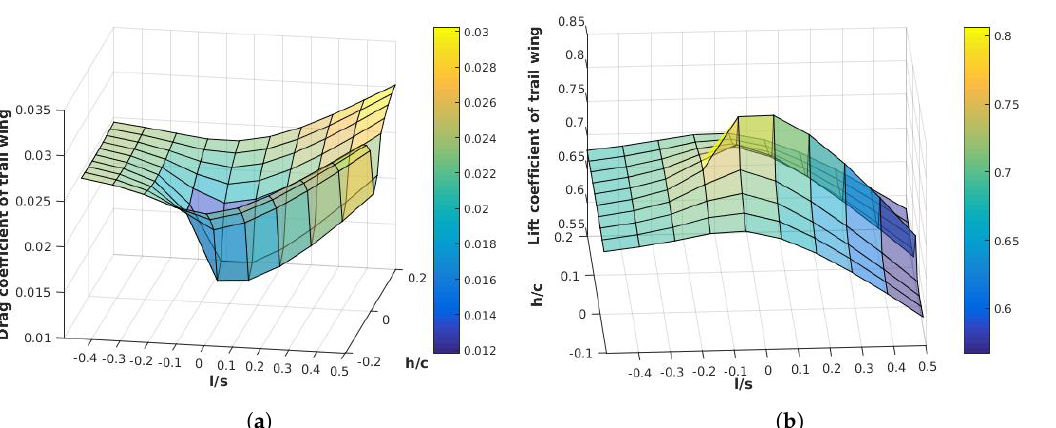
Figure 10. Three-dimensional response surfaces of absolute quantities against relative positions: ( a ) drag coefficient; and ( b ) lift coefficient, for VLM